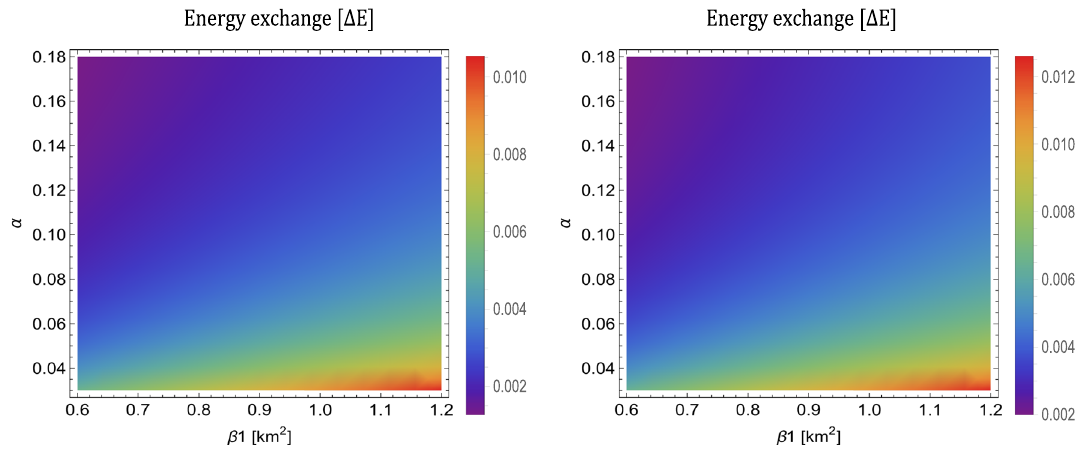
Fig. 10 Left panel: The variation of energy exchange (cid:18) E on r − β 1 plane for C = 0 . 0043 km − 2 , α = 0 . 1 and A / B = − 0 . 5. Right panel: The variation of energy exchange (cid:18) E on r − β 1 plane for C = 0 . 0043 km − 2 , α = 0 . 1 and A / B = 0 . 5